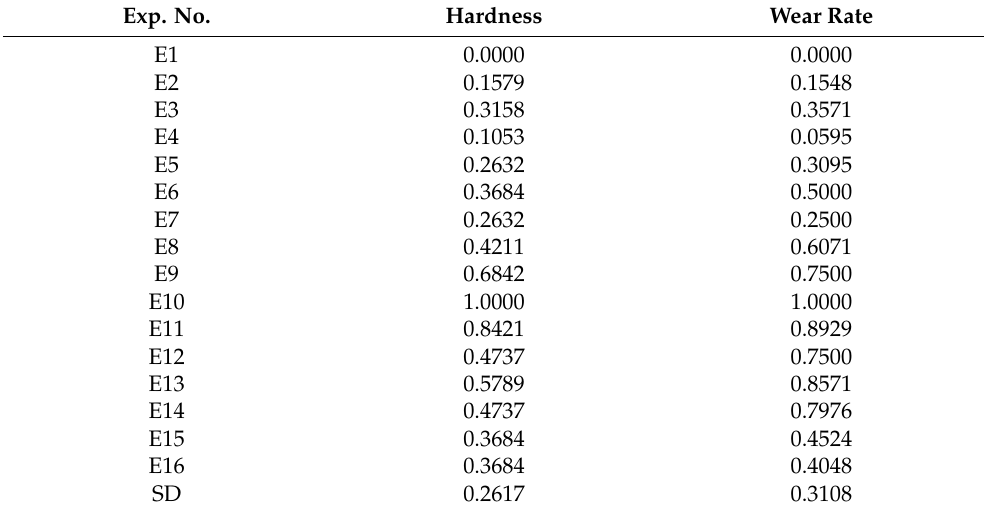
Table 5. Normalization of outputs.